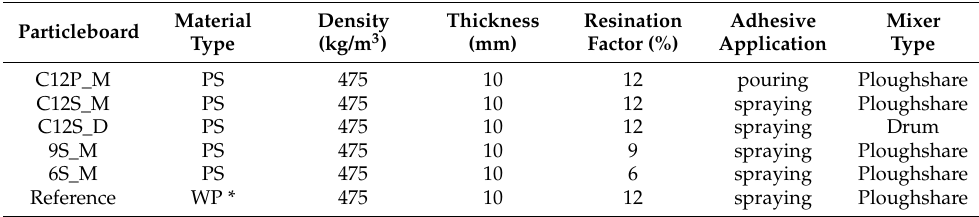
Table 1. Experimental design for the particleboard fabricated with wood shavings bonded with 6%, 9%, and 12% urea-formaldehyde (UF)